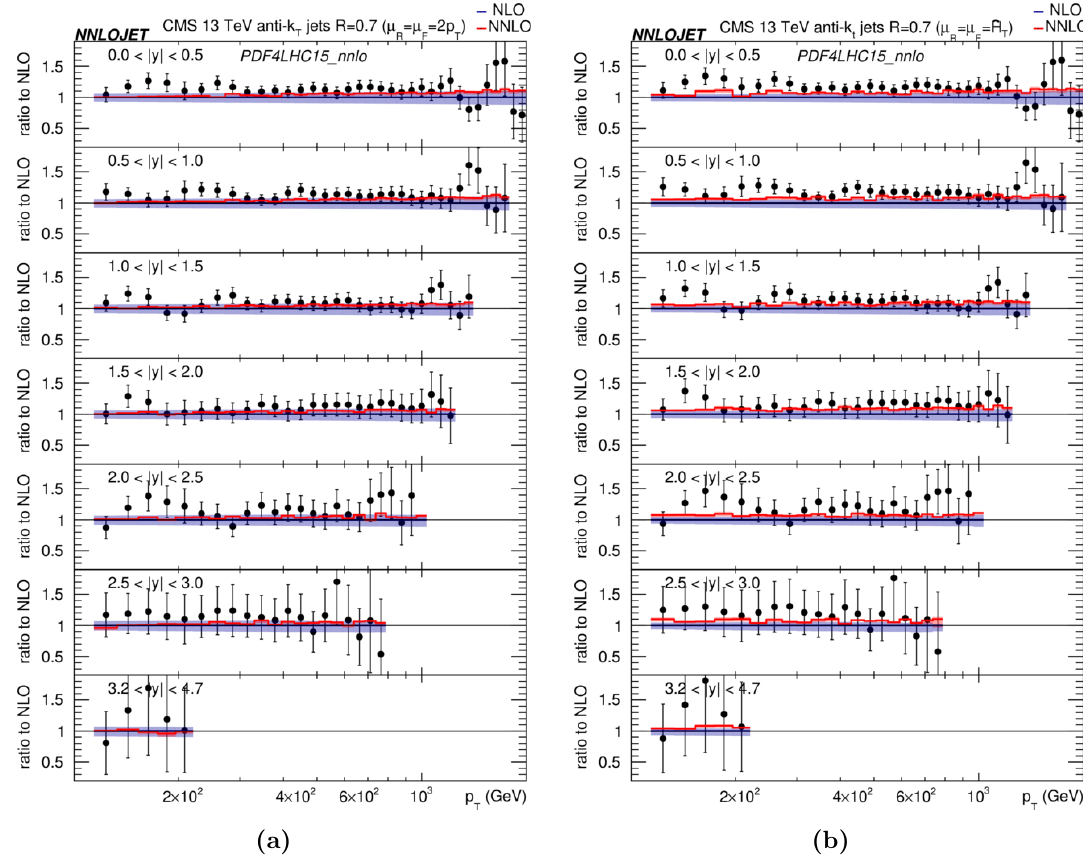
Figure 21 . Double-di(cid:11)erential single jet inclusive cross-sections measurement by CMS [12] and NNLO perturbative QCD predictions as a function of the jet p T in slices of rapidity, for anti- k T jets with R = 0 : 7 normalised to the NLO result for (a) (cid:22) = 2 p T , (b) (cid:22) = ^ H T scales. The shaded bands represent the scale